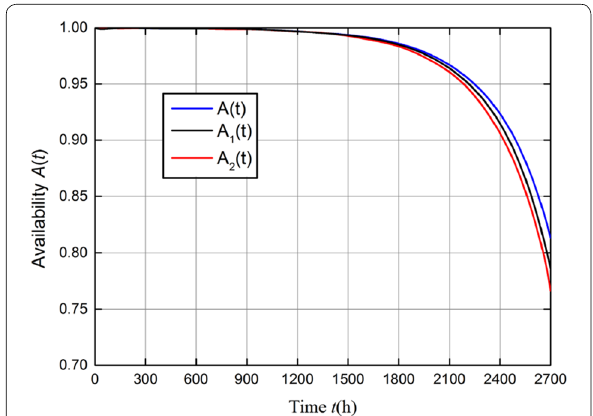
Figure 13 Availability of the belt drive system